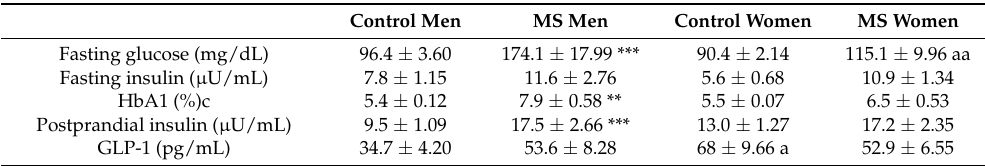
Table 2. Mean values ± standard error of fasting plasma glucose, fasting insulin, glycosylated hemoglobin, postprandial insulin, and plasma GLP-1 levels in the four groups